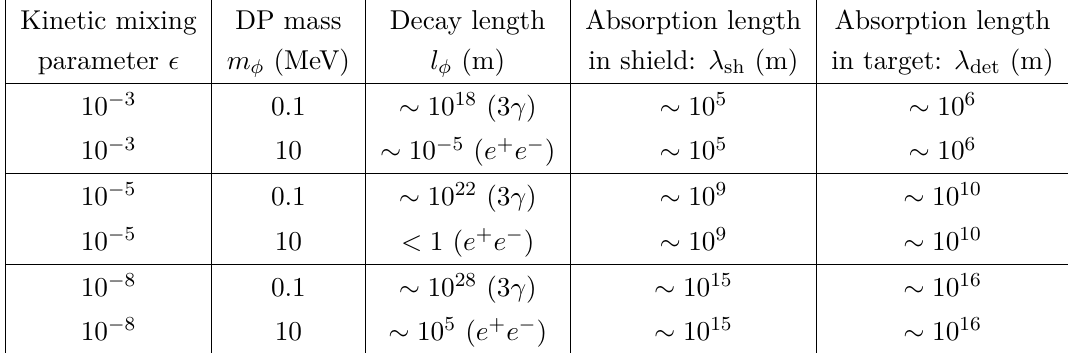
Table 1 . Dark photon decay and absorption length scales for three different kinetic mixing pa- rameters and for two different DP mass values. These length scales depend on the fractional of DP energy (x) and electron energy (E) at the DP point of production, while for the allowed ranges of x and E the length scale values given in the table do not